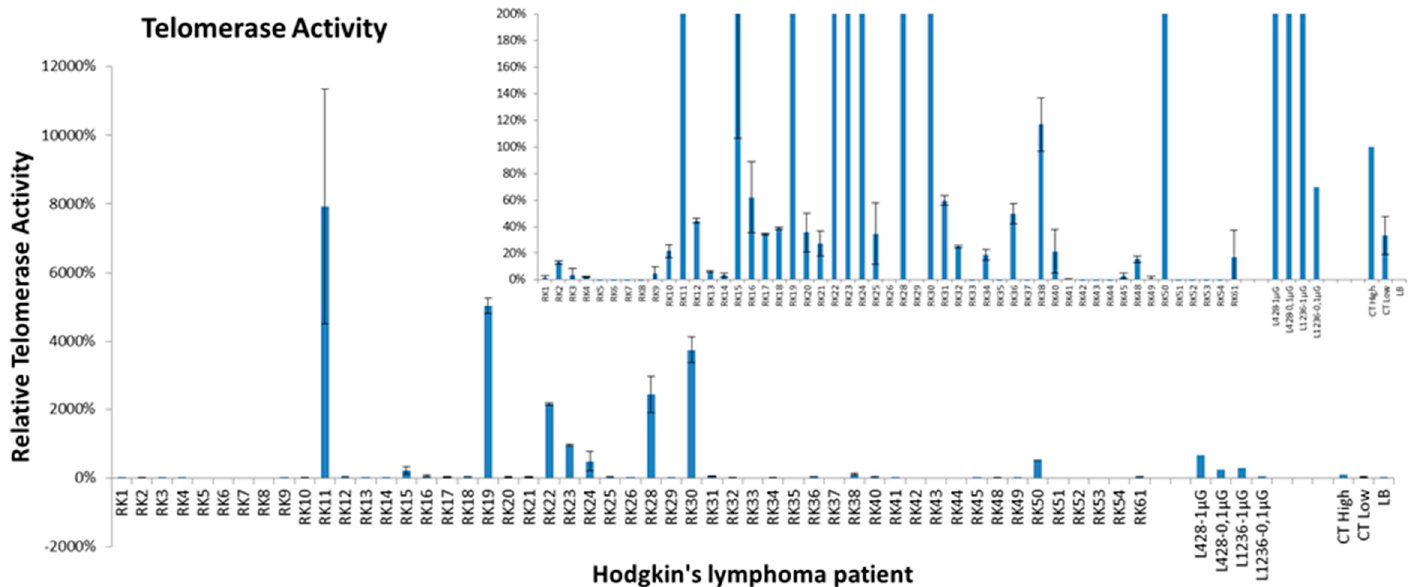
Figure 16. Detection of high telomerase activity in circulating lymphocytes of ten HL patients using the repeat amplification protocol (TRAP). Histogram displaying the fold change of relative telomerase activity in HL patients relative to that of CT (positive control equal to 100%). Telomerase activity of the L428 and L1236 HL cell lines served as a second control. The experiments were performed in triplicate.